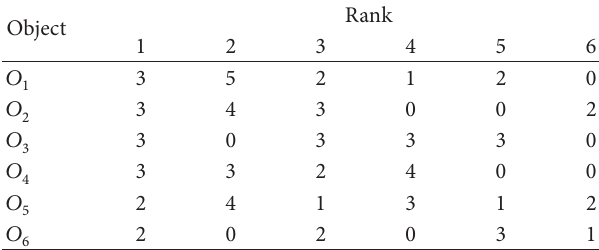
Table 4: Objects versus 𝑖 th ranks for the page shown in Figure 10, which is derived from Table